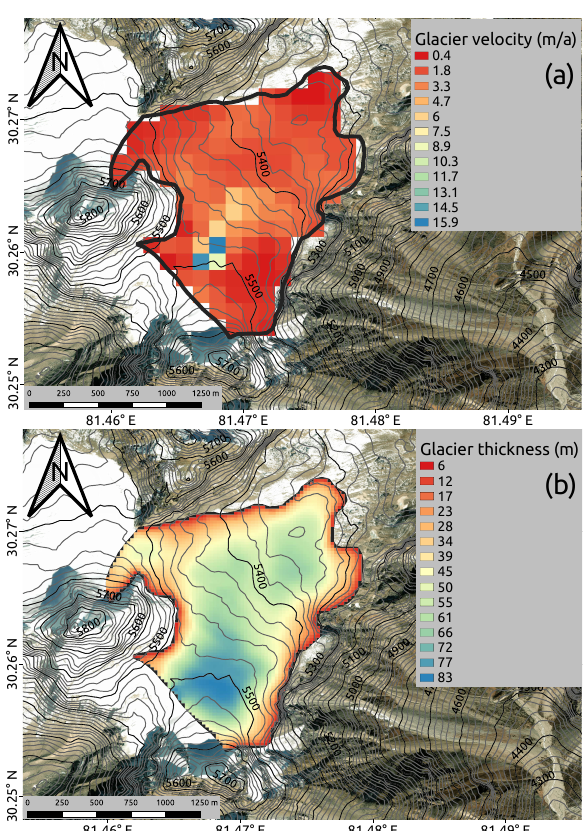
Figure A1. Glacier velocity ( a ) according to Dehecq et al. ([47], dataset: [48]]) and Glacier thickness ( b ) according to Farinotti et al. ([22], dataset: [46]]) of Halji glacier with a satellite image map in the background [55]. For the location of Halji glacier please refer to Figure 1.